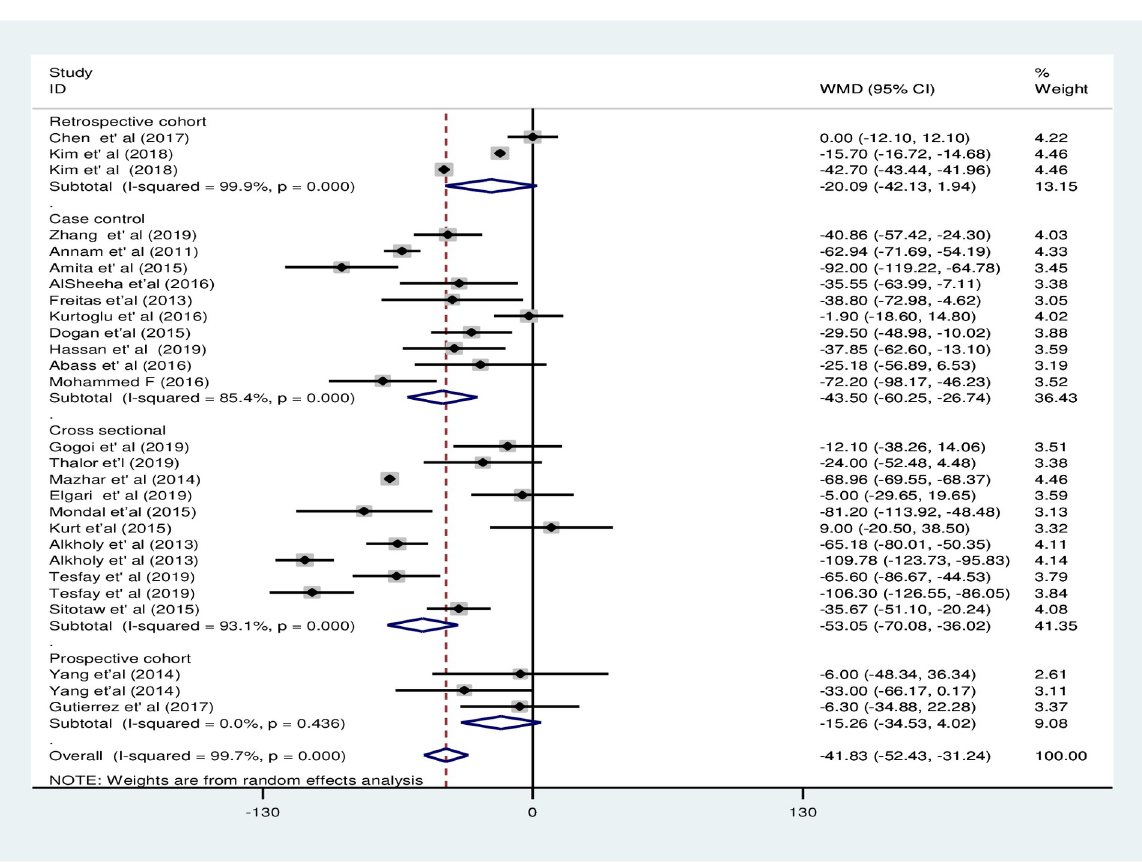
Fig 8. Forest plot of subgroup analysis for the pooled WMD estimate of PC by study design using random effect model.